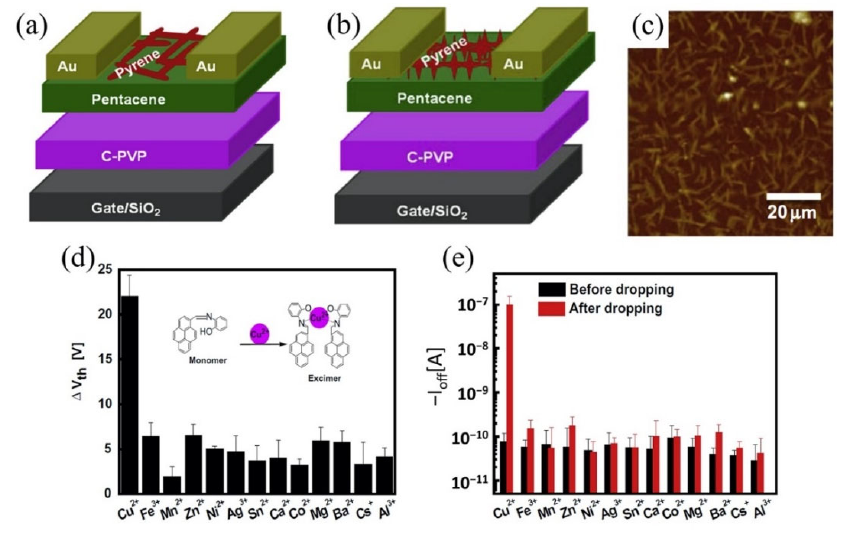
Figure 15. ( a ) Structure of OFET device functionalized with pyrene derivative. ( b ) Self ‐ assembly of star ‐ shaped pyrene derivatives in the presence of Cu 2+ . ( c ) AFM image of self ‐ assembled star ‐ shaped pyrene derivatives. ( d ) FET voltage threshold (V TH ) change in the presence of Cu 2+ . ( e ) Off current change in the presence of Cu 2+ . Reprinted from [268], Copyright 2014, with permission from Elsevier.